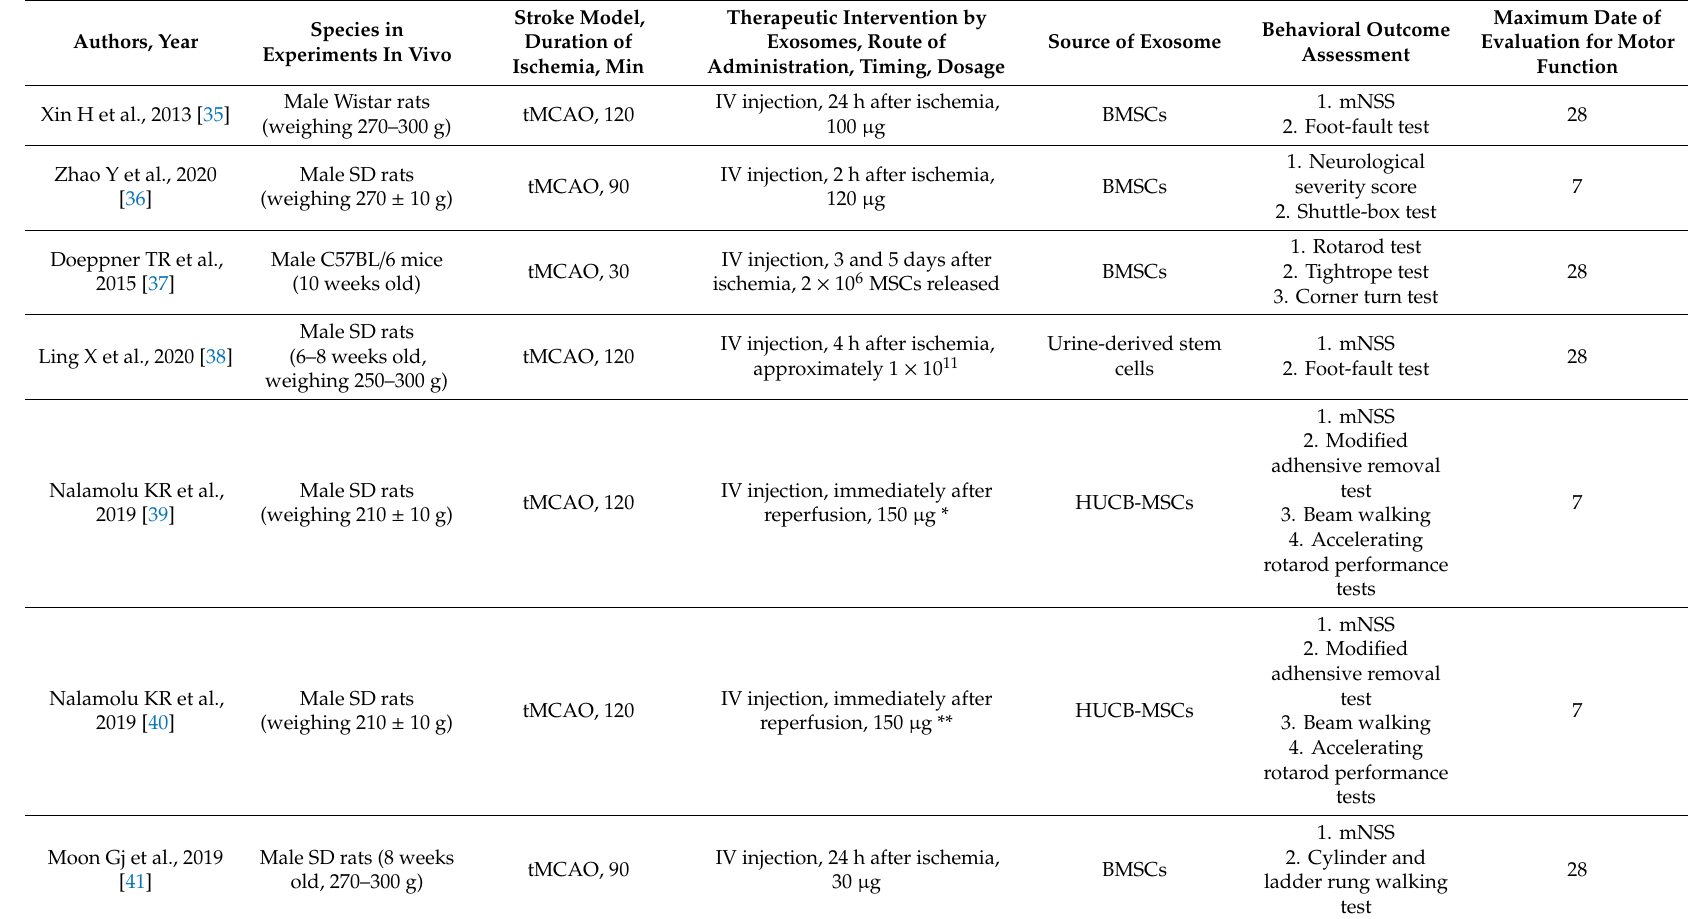
Table 1. Characteristics of preclinical studies of exosome treatment for